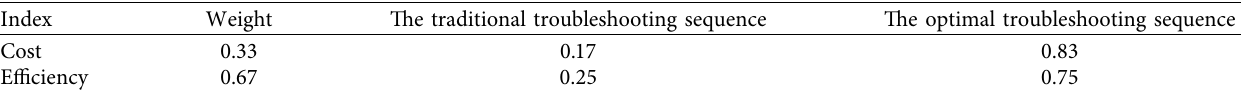
Table 6: Evaluation